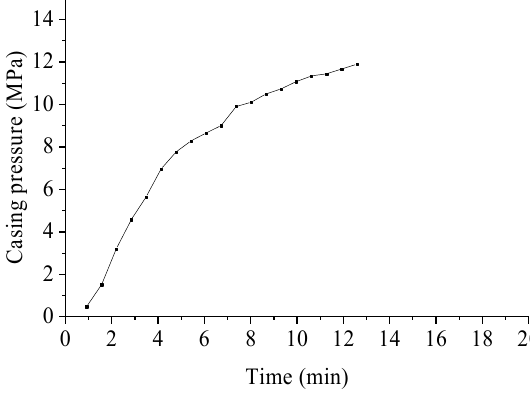
Figure 14. Time sequence diagram of the casing pressure during well shut-in.